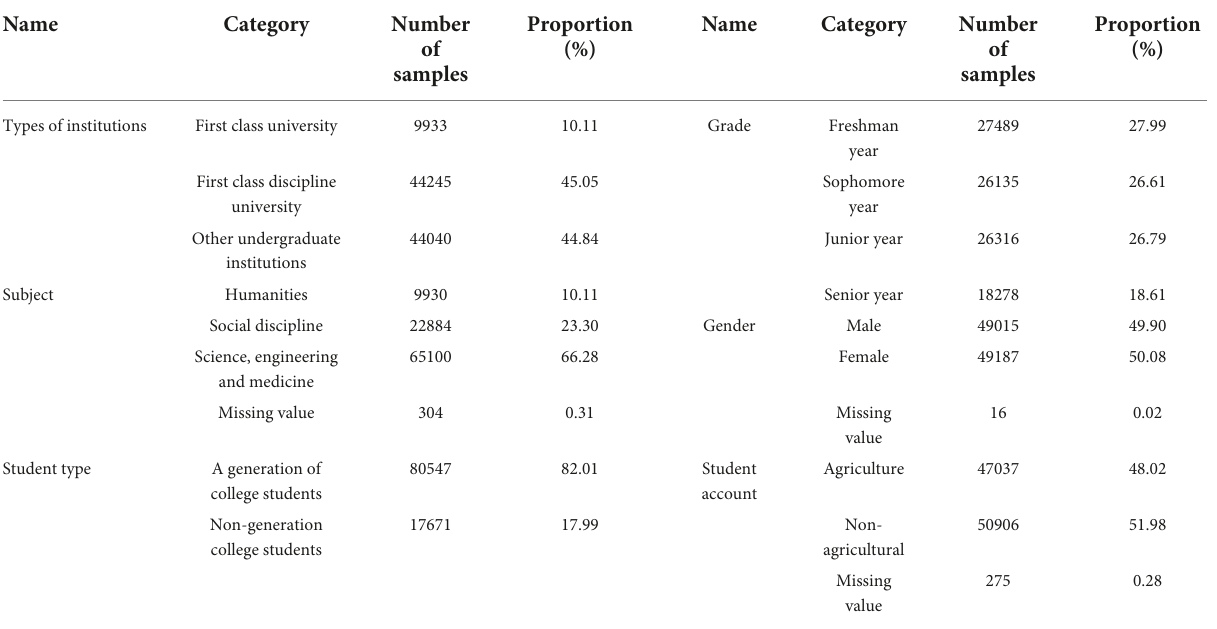
FIGURE1 Conceptual model.